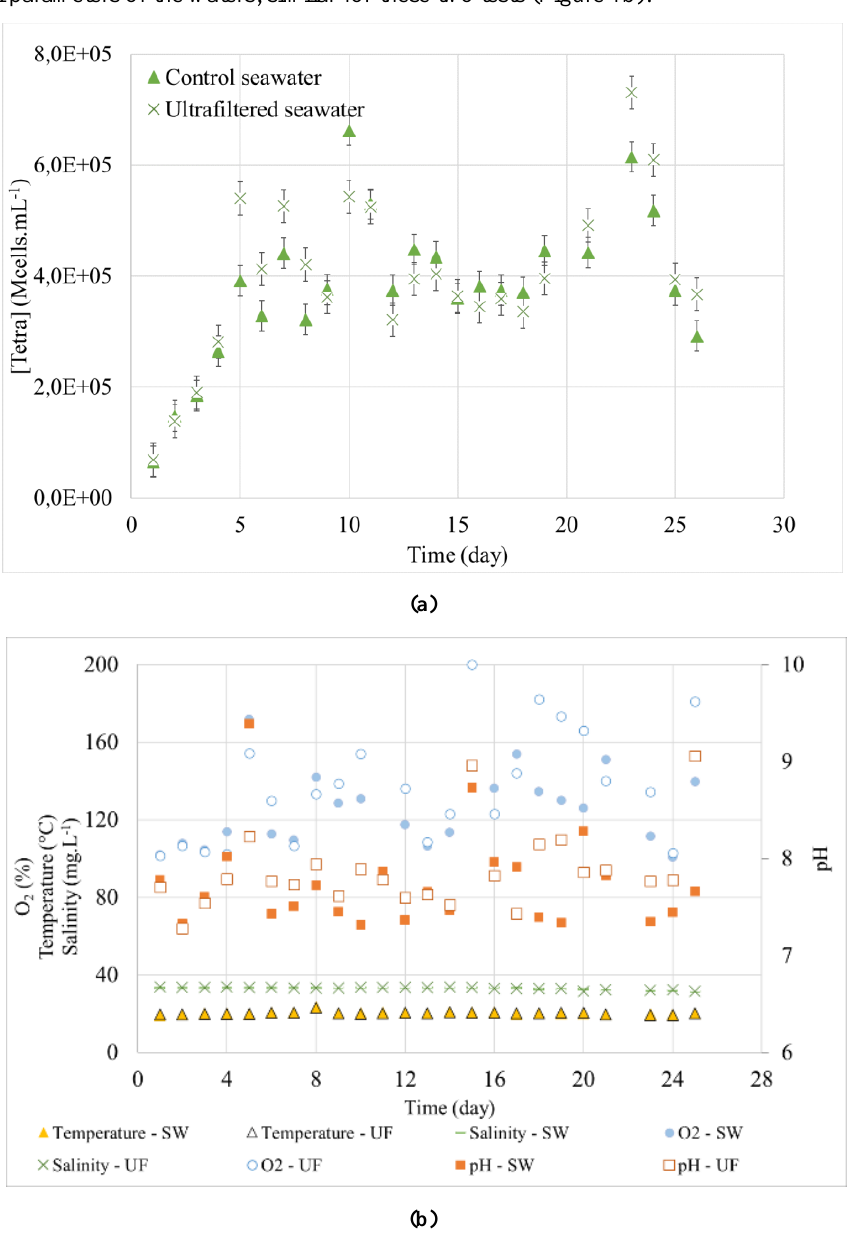
Figure 1. Monitoring of Tetraselmis concentrations (a) and physico-chemical parameters (b) - SW: seawater treated with common processes (filtrations + UV) and UF: ultrafiltered